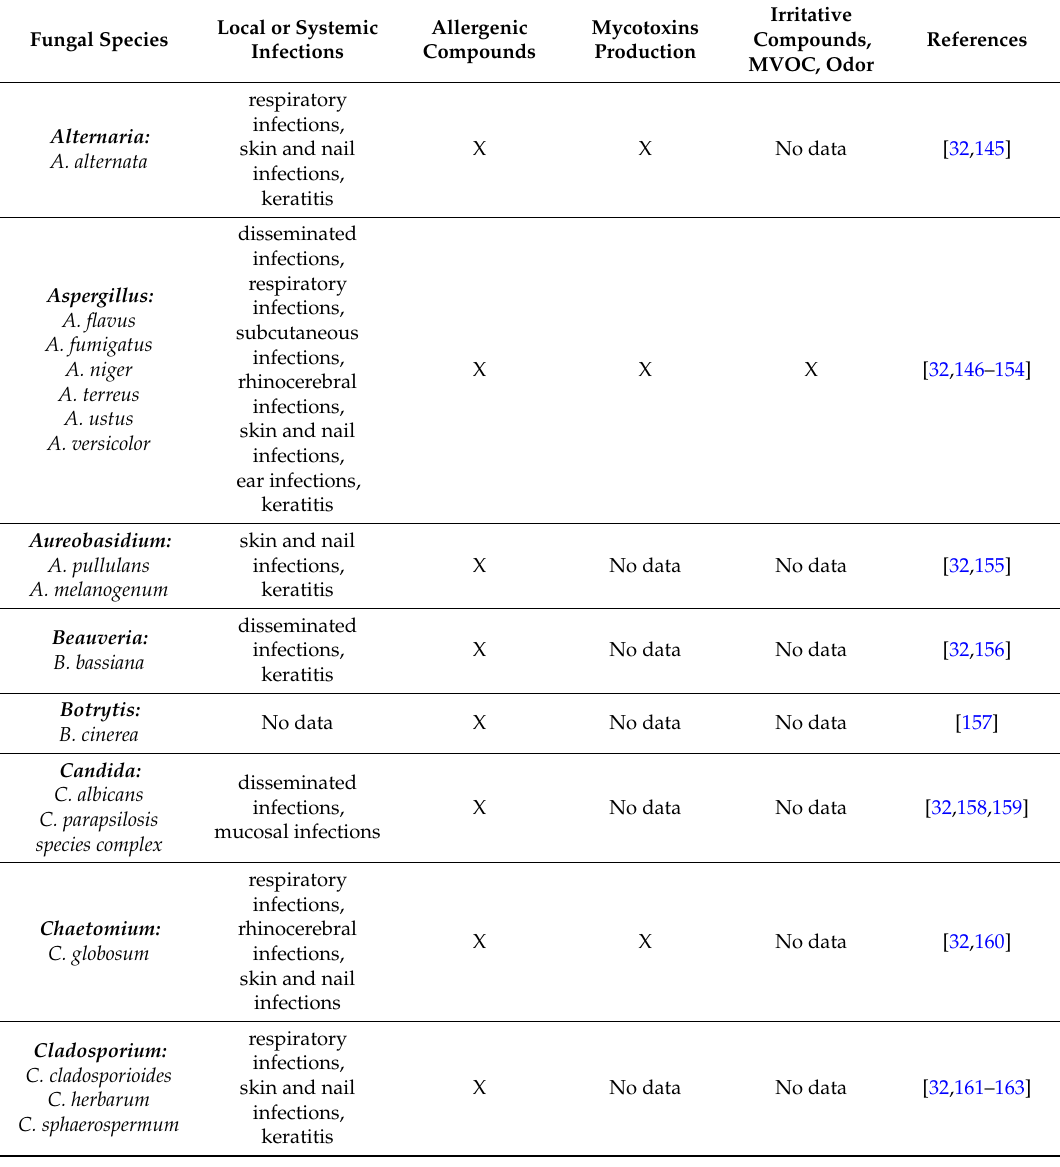
Table 2. The list of the most common fungi isolated from different water sources in Europe, recognised as causative agents of opportunistic infections and other health effects on human health. Irritative Local or Systemic Allergenic Mycotoxins Compounds, Fungal Species Infections Compounds Production MVOC,